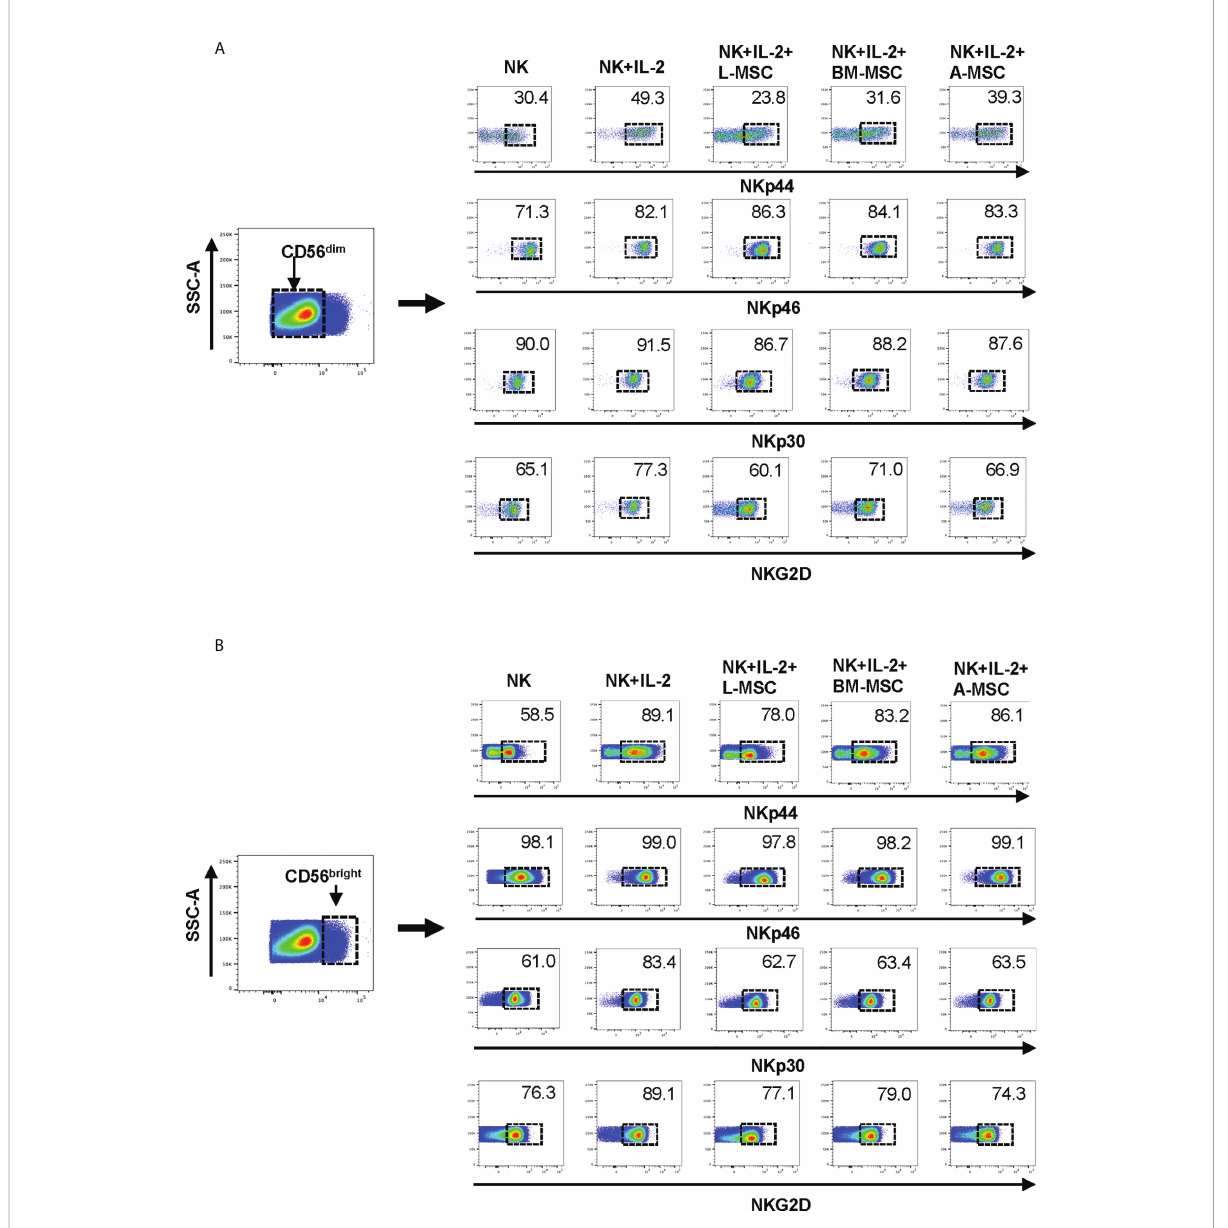
FIGURE 4 Expression of the NK receptors on CD56 dim and CD56 bright NK cells after co-culturing with MSC. After co-culturing with MSC for 3 days (with 100 U/ml rhIL-2), NK cells were harvested, and surface expression of NKp30, NKp44, NKp46 and NKG2D was examined by fl ow cytometry, after gating for the CD56 dim and CD56 bright populations. (A) A representative dot plot of 4 independent experiments shows that among the CD56 dim NK cells, the percentage of NKp44-positive and NKp46-positive cells increase after stimulation with IL-2. L-MSC decreases the percentage of both NKp44-positive and NKG2D-positive NK cells. (B) A representative dot plot of 4 independent experiments shows that the percentage of NKp30-positive cell among the CD56 bright NK population increases after stimulation with IL-2, and this is reversed by all three types of MSC. The mean percent-positive values ± SD of the cumulative data using each of the MSC lines are presented in Table